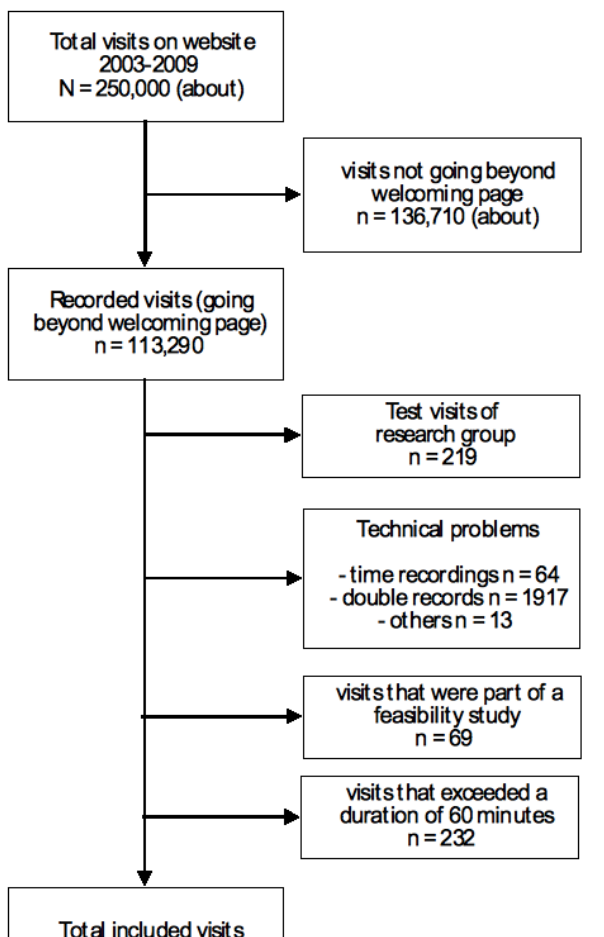
Figure 3. Inclusion and exclusion of records used in the